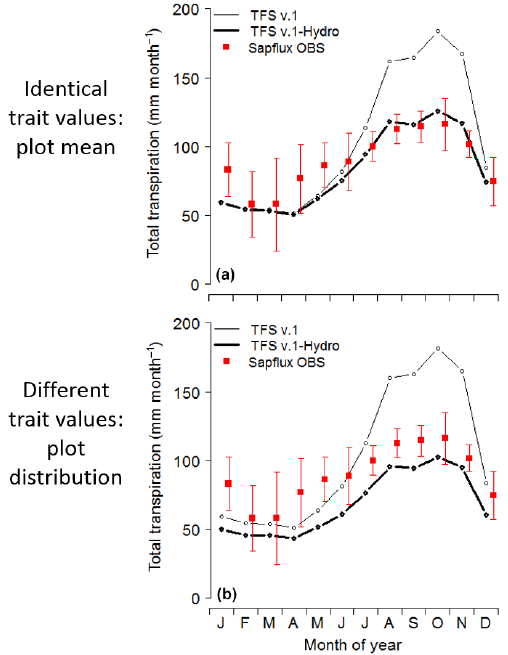
Figure 13. Simulated and observed stand-level total transpiration at Caxiuana National Forest, Brazil. Model simulations were car- ried out where individuals were either (a) forced to take on identi- cal plot-mean trait values (LMA = 96.1gm − 2 , WD = 0.73gcm − 3 , N L = 20 . 9mgg − 1 , P L = 0 . 59mgg − 1 ) , or (b) allowed to vary ac- cording to the plot-level trait